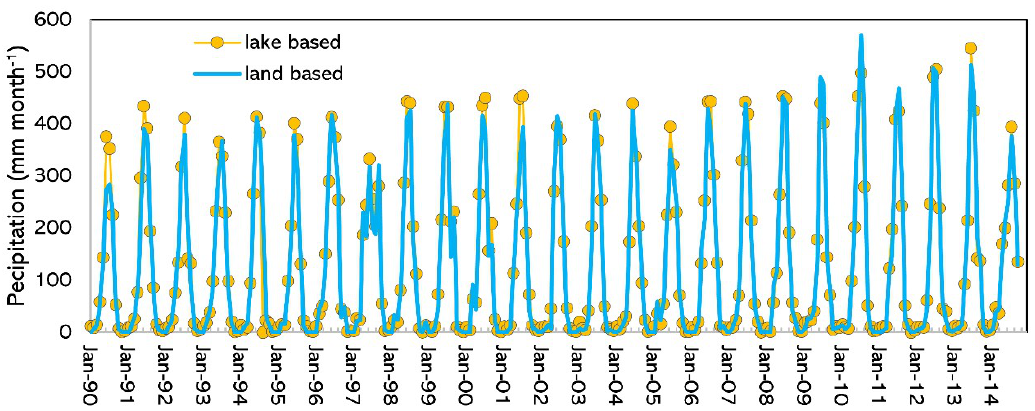
Figure 5. Monthly precipitation for Lake Tana for six land‐based weather stations and eight “lake + land”‐based weather stations consisting of the Jigrfa station on the east shore and a station on Dek island plus six land‐based stations. Figure 3 shows the location of the rainfall stations.